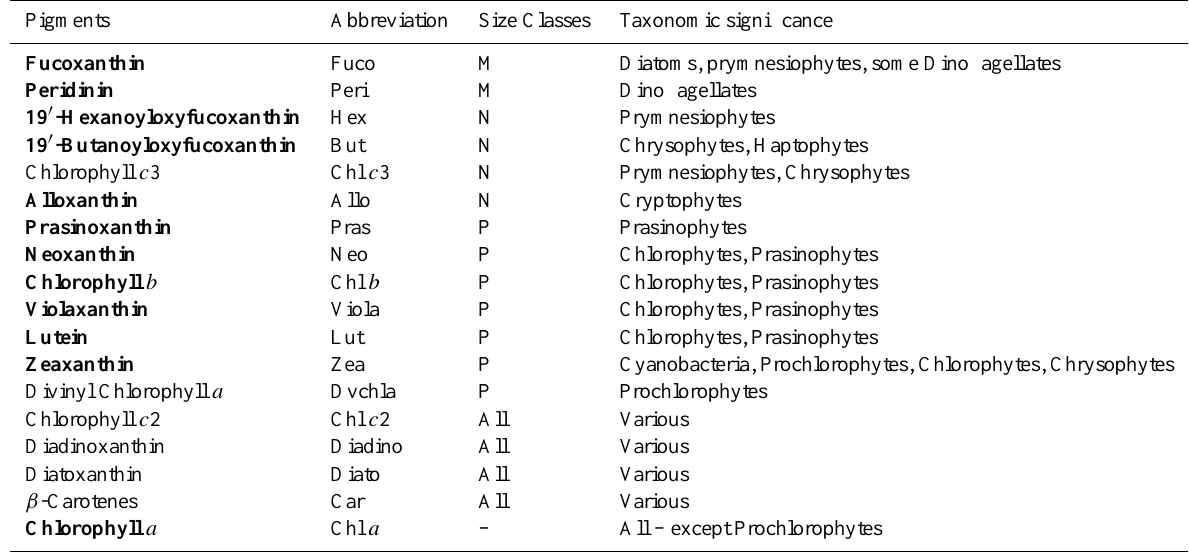
Table 1. List of the pigments and their taxonomic significance (Wright and Jeffrey, 1997). The name of the twelve pigments used in CHEM- TAX to distinguish between the eight phytoplankton classes are highlighted in bold. P: Picoplankton ( < 2µm), N: Nanoplankton (2–20µm), M: Microplankton ( >